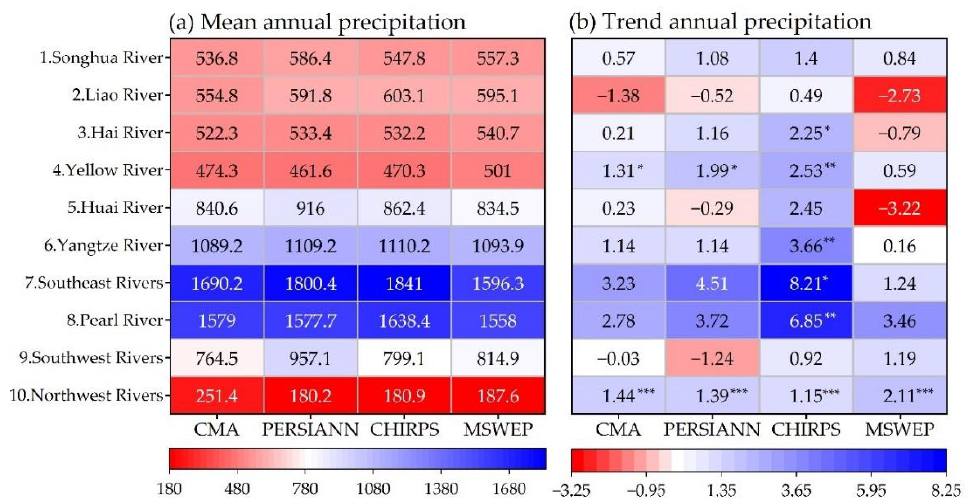
Figure 4. Spatial mean and trend distribution of the observational precipitation and RSPEs. The numbers 1 – 10 in ( a ) represent the 10 first-level basin IDs, and the number in the lower-left corner of each subplot denotes the mean value over mainland China ( a – d ). The ‘+’ symbols in ( e – h ) indicate that the trend is significant for the current grid at a significance level of p = 0.05. The observed data in Taiwan were not available; thus, the data for RSPEs in this area are not presented to compare the spatial patterns directly.